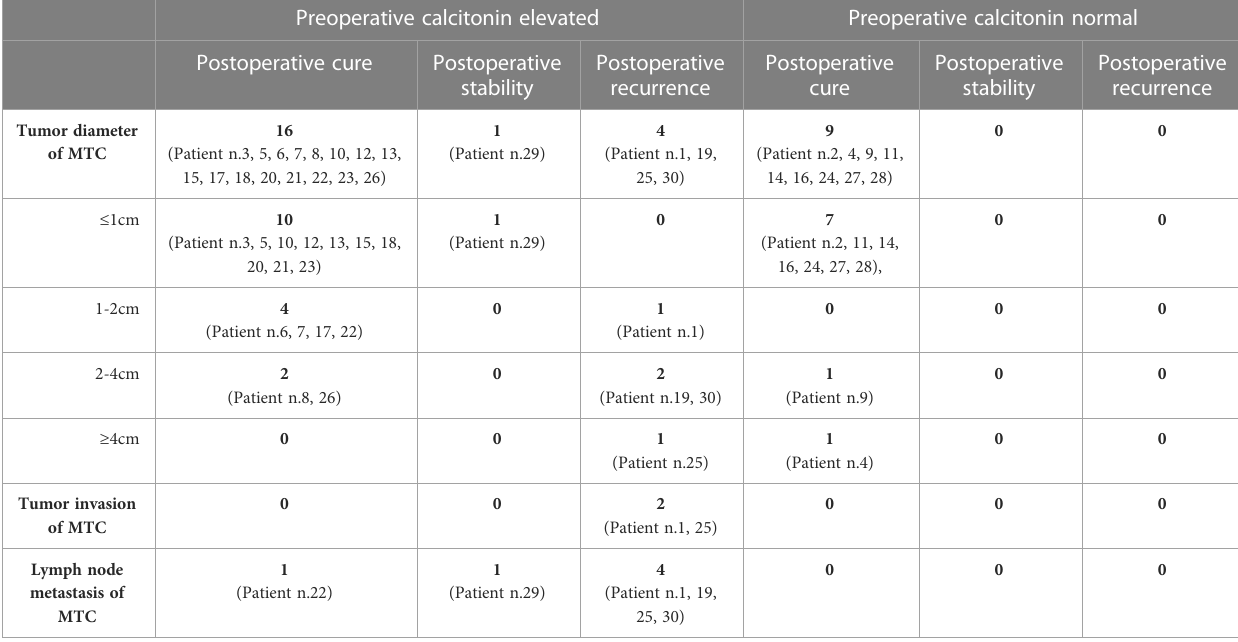
TABLE 4 Relationship between calcitonin changes and clinicopathological features.